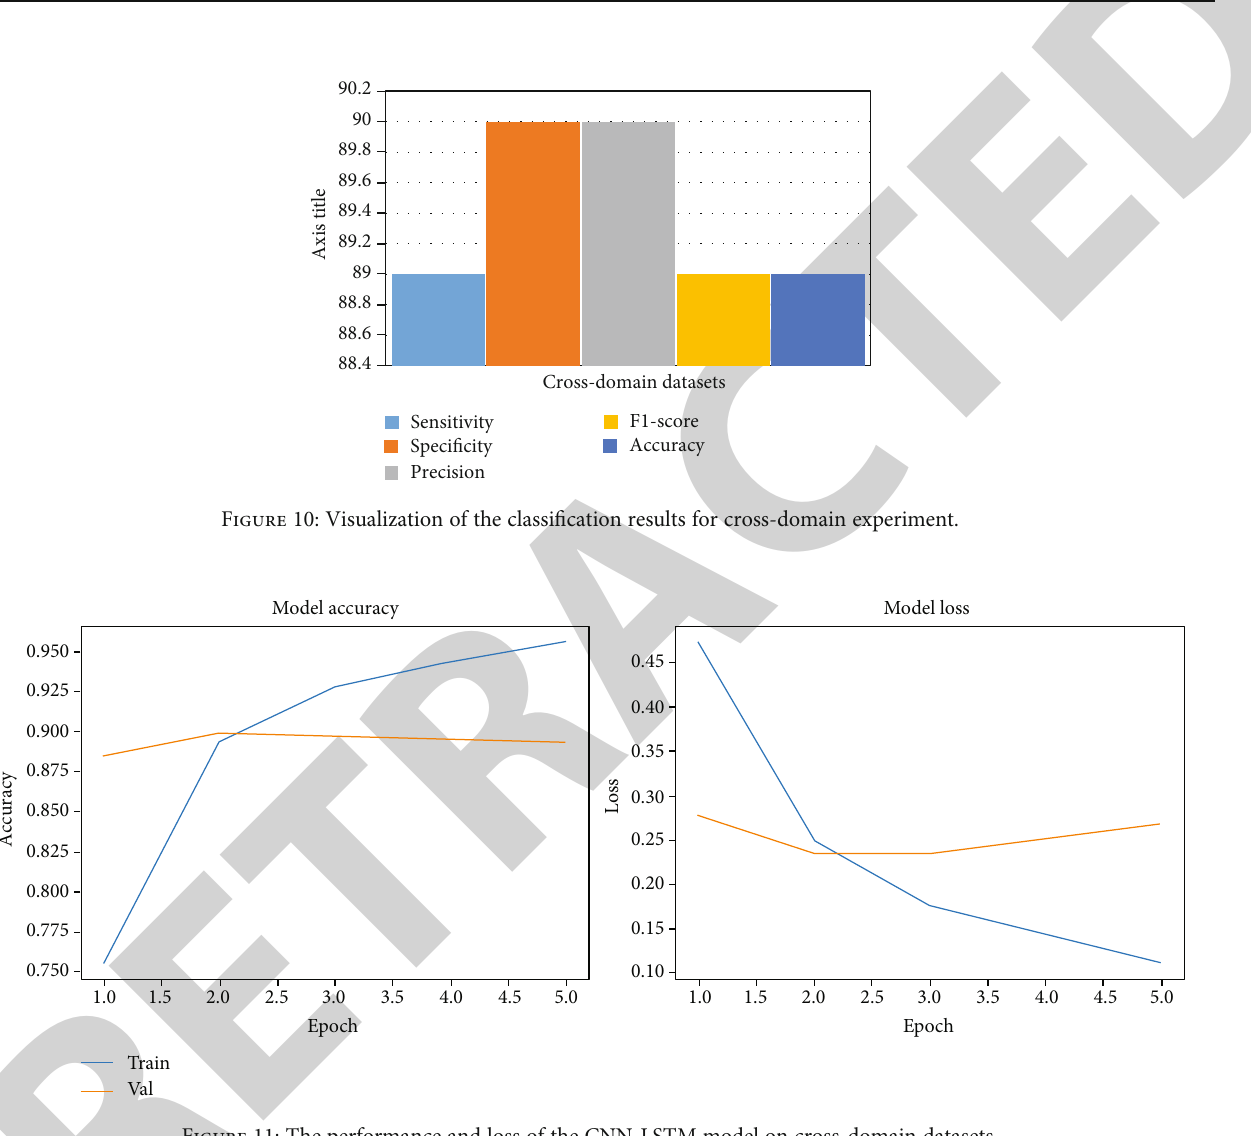
Figure 11: The performance and loss of the CNN-LSTM model on cross-domain